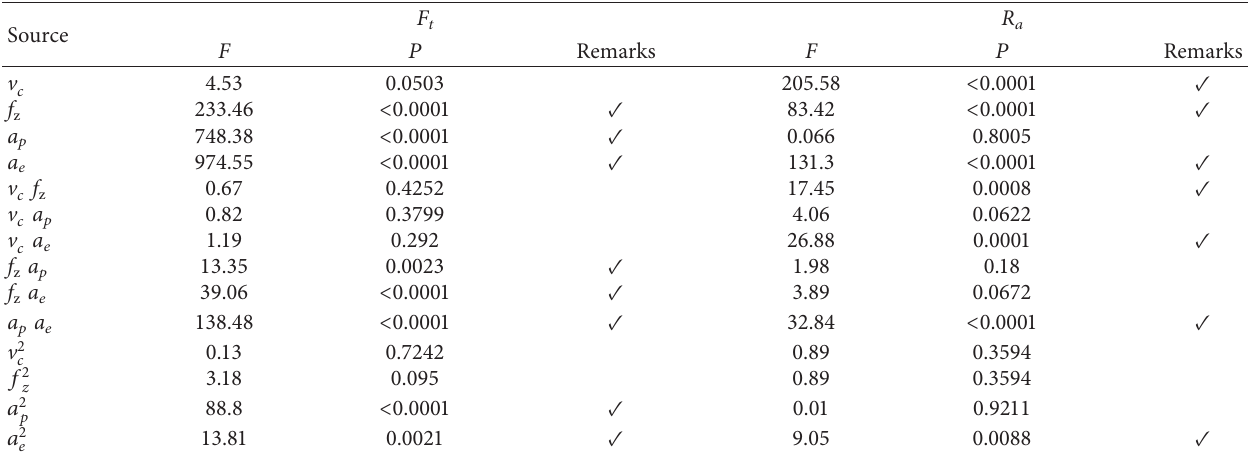
Figure 2: Correlation of predicted values versus experimental values: (a) F t ; (b) R a . Table 6: The ANOVA for F t and R a